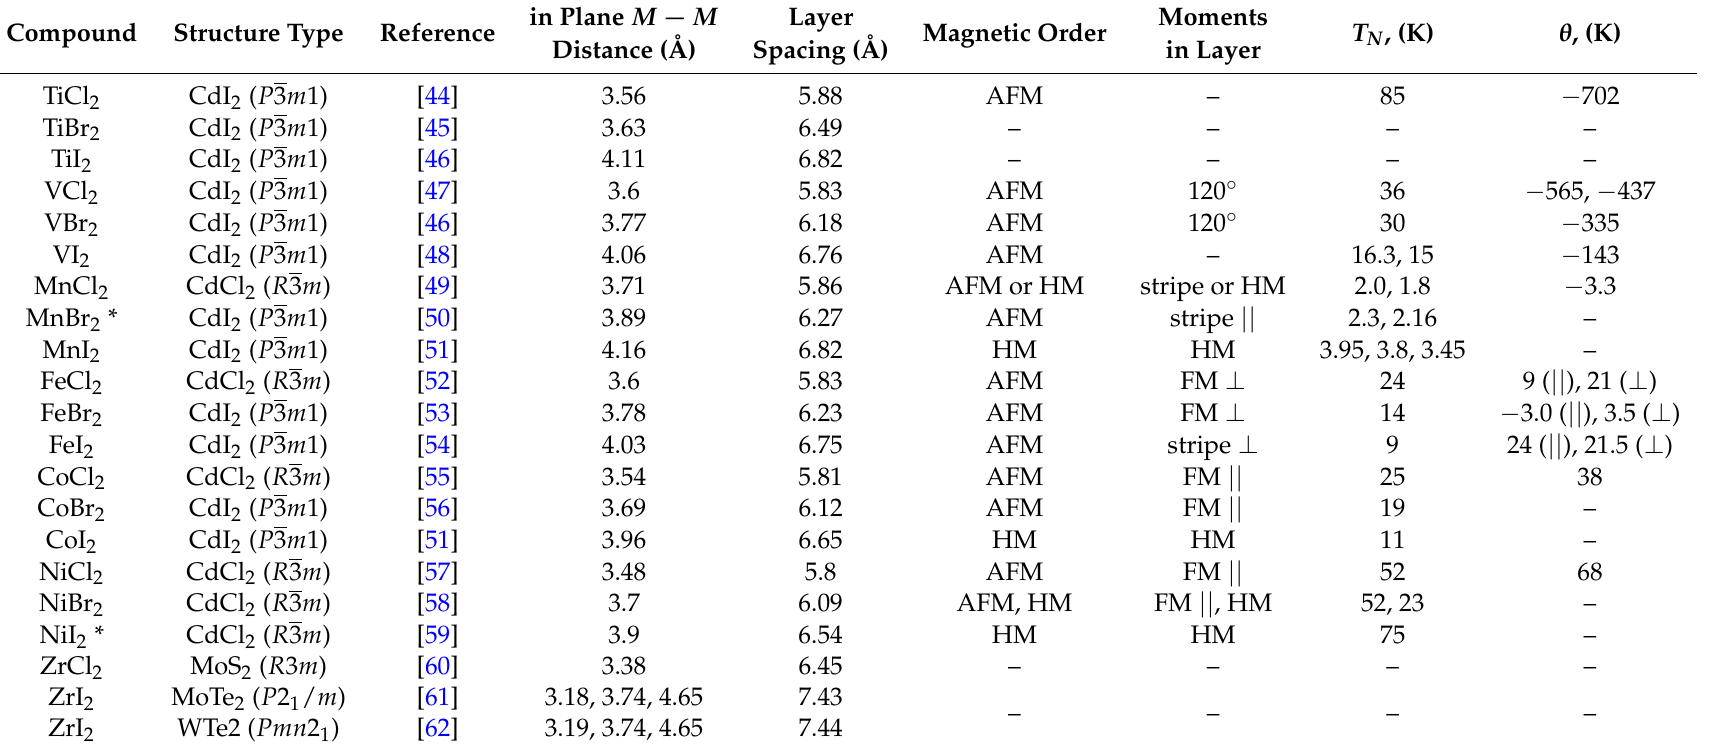
Table 1. Summary of structural and magnetic data for layered MX 2 compounds with partially filled d -shells. A * indicates that the compound is known to undergo a crystallographic phase transition above or below room temperature. “Magnetic order” refers to long range 3D magnetic order, and is given as antiferromagnetic (AFM), ferromagnetic (FM), or helimagnetic (HM). “Moments in layer” refers to the arrangement of the magnetic moments within a single layer, with || and ⊥ indicating whether the moments are directed parallel to the plane of the layer (in plane) or perpendicular to it (out of plane), respectively. Ordering temperatures ( T N ) and Weiss temperatures ( θ ) are given. References for the magnetic data can be found in the associated